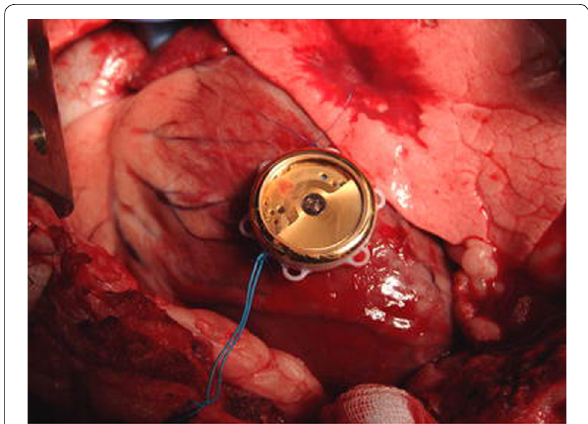
Fig. 5 Attachment of mass imbalance oscillation generator (MIOG) to the left ventricle of Swiss alpine (sheep Reproduced with permis‑ sion from Ref. [38], © Biomedical Engineering Society 2012)